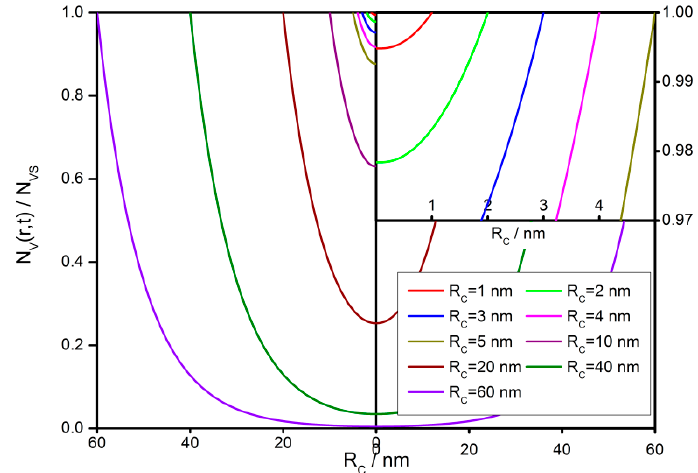
Figure 12. Steady-state distribution of oxygen vacancies in semiconductor grains with a radius of 1 to 60 nm.